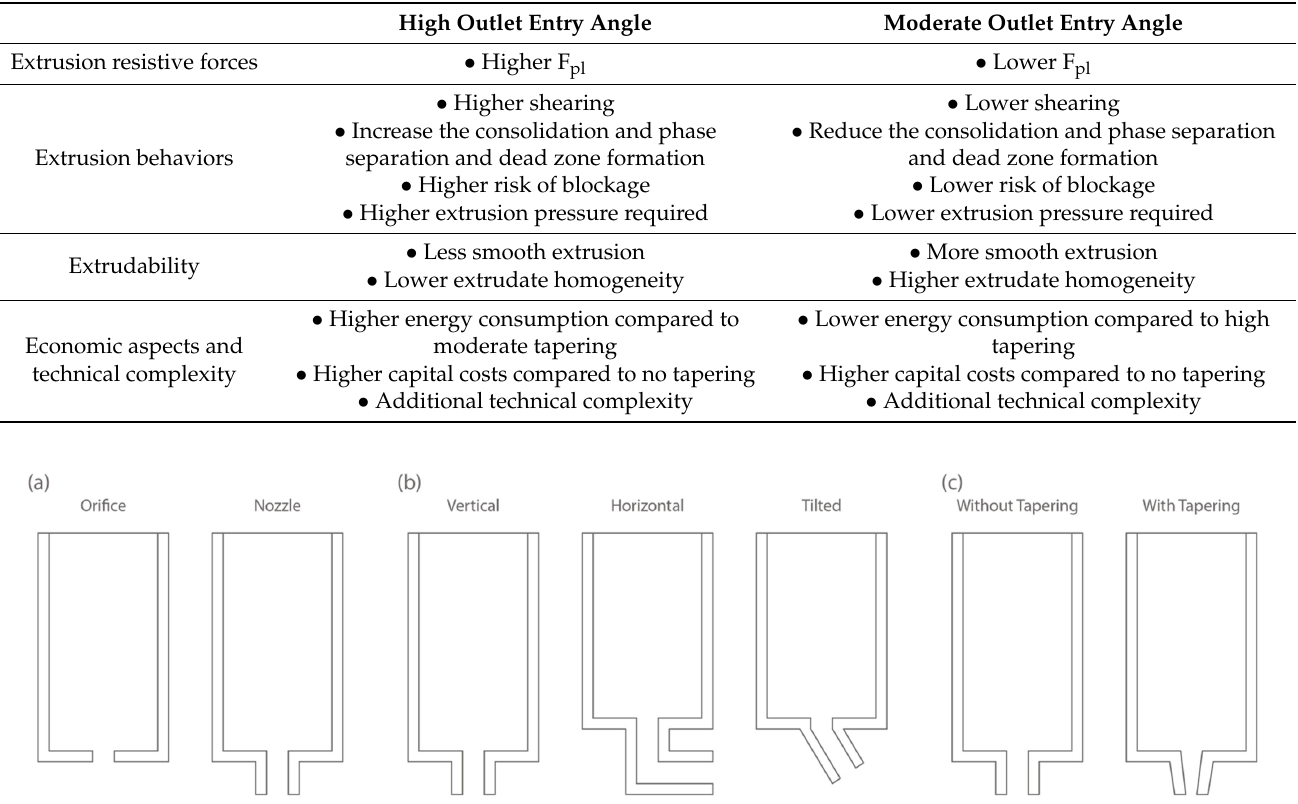
Figure 5. The schematic sketch of ( a ) outlet form: orifice and nozzle; ( b ) outlet orientation: vertical, horizontal and tilted; and ( c ) outlet tapering; without tapering and with tapering.